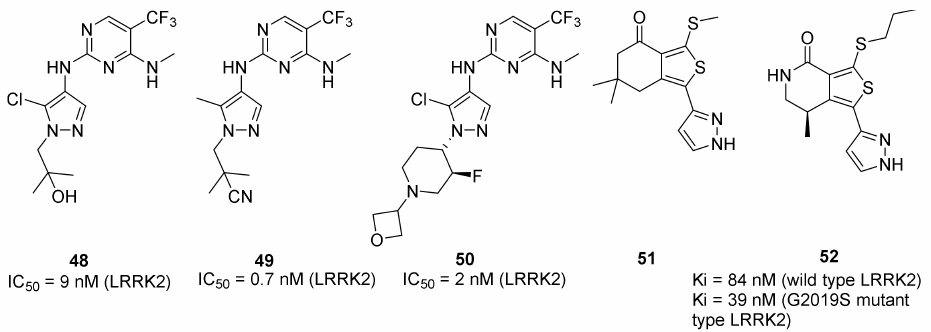
Figure 56. Structures of pyrazole-based LRRK inhibitors and their IC 50 /Ki